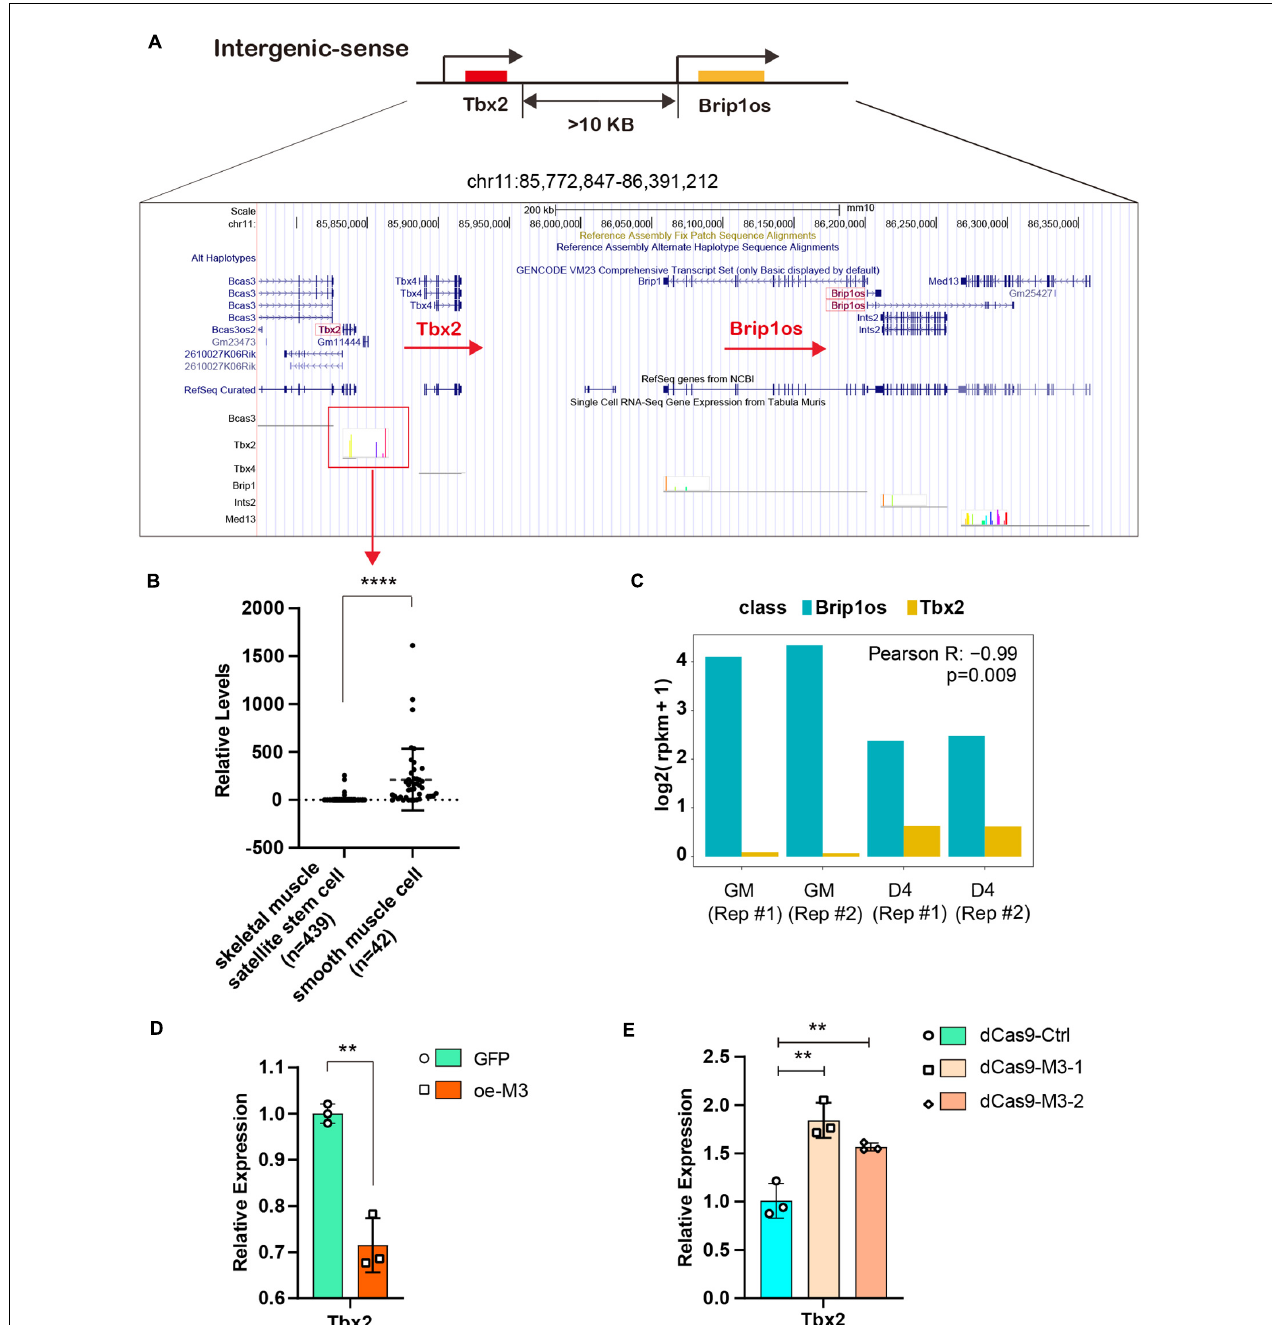
FIGURE 7 | METTL3/m 6 A/Brip1os/Tbx2 axis in muscle development. (A) The genomic location of lncRNA Brip1os and its adjacent mRNA Tbx2. (B) Tbx2 expression data from public record of single cell RNA-seq gene expression of Tabula Muris data. (C) Brip1os and Tbx2 expression levels in our RNA-seq data. Pearson correlation analysis was performed to estimate expression correlation between two genes. (D) qRT-PCR shows the expression of Tbx2 when METTL3 overexpressed. (E) qRT-PCR shows the expression of Tbx2 when METTL3 was knockdown. Data are presented as Mean ± SD; p value: ** p < 0.01, **** p <